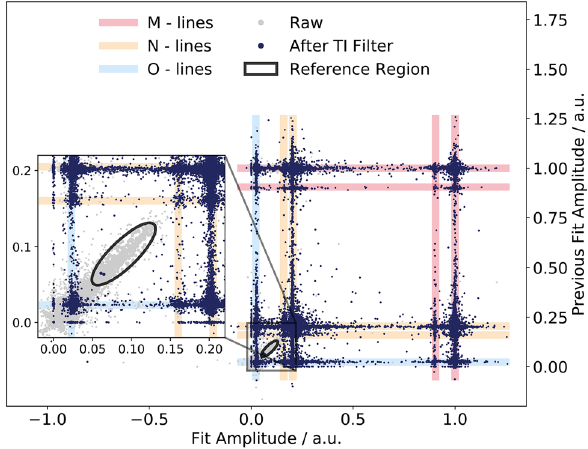
Fig. 8 Fit amplitude of a trace versus fit amplitude of the preceding trace in the same detector channel before and after a time information filter is applied. Data points from one detector channel of the two-day dataset are shown. 163 Ho events are mostly located on lines parallel to the main axes corresponding to the individual resonances of the 163 Ho spectrum. High densities appear at the intersections of two such lines. TheinsetshowsamagnificationoftheregionbetweentheN-resonances and O-resonances together with a structure of correlated amplitudes originating from mobile phone signals. The ellipse-shaped reference regionisusedtoestimatethebackgroundrejectionefficiencyformobile phone signals. Data points within the ellipse are magnified for better readability. One can see that nearly all of the signals within the ellipse are discarded by the time information filter while most of the 163 Ho signals are